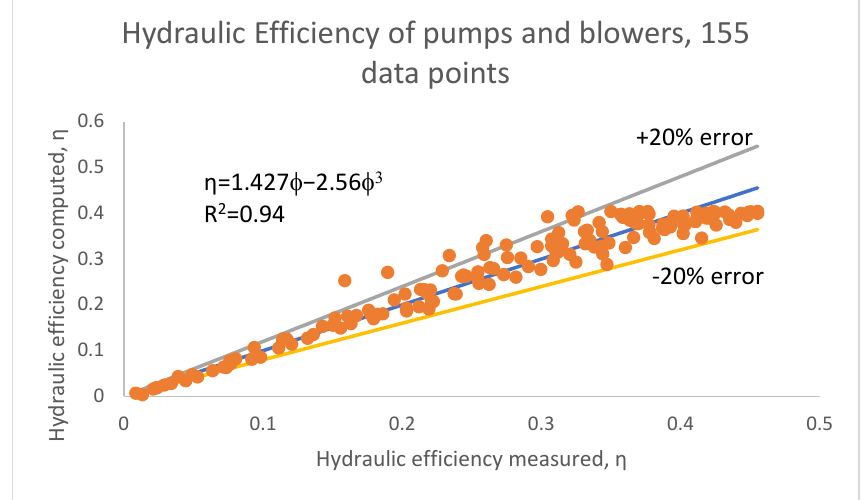
Figure 5. Hydraulic efficiency of one ‐ side impeller machines as estimated by the correlation.